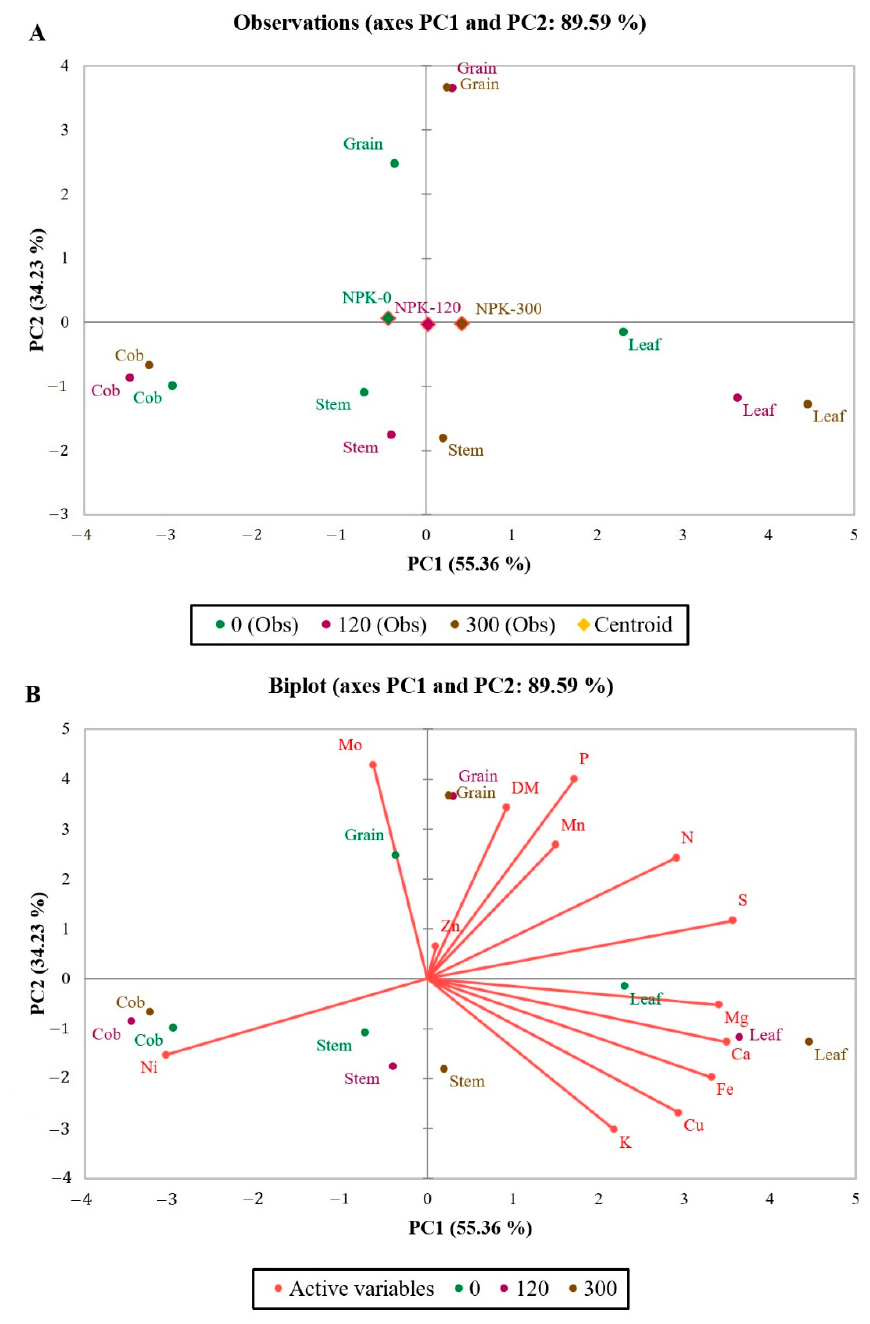
Figure 1. Principal component analysis (PCA) observation plot ( A ) and biplot ( B ) of the first two components performed on dry matter production and nutrient composition of maize tissues affected by fertilizer levels. Centroids showing segregation of maize tissues and fertilizer levels on axis PC1 and PC2 based on dry matter production and nutrient composition. (N (nitrogen), P (phosphorus), DM (dry matter), K (potassium), Mn (manganese), S (sulphur), Mo (molybdenum), Mg (magnesium), Ca (calcium), Fe (iron), Cu (copper), Ni (nickel)).